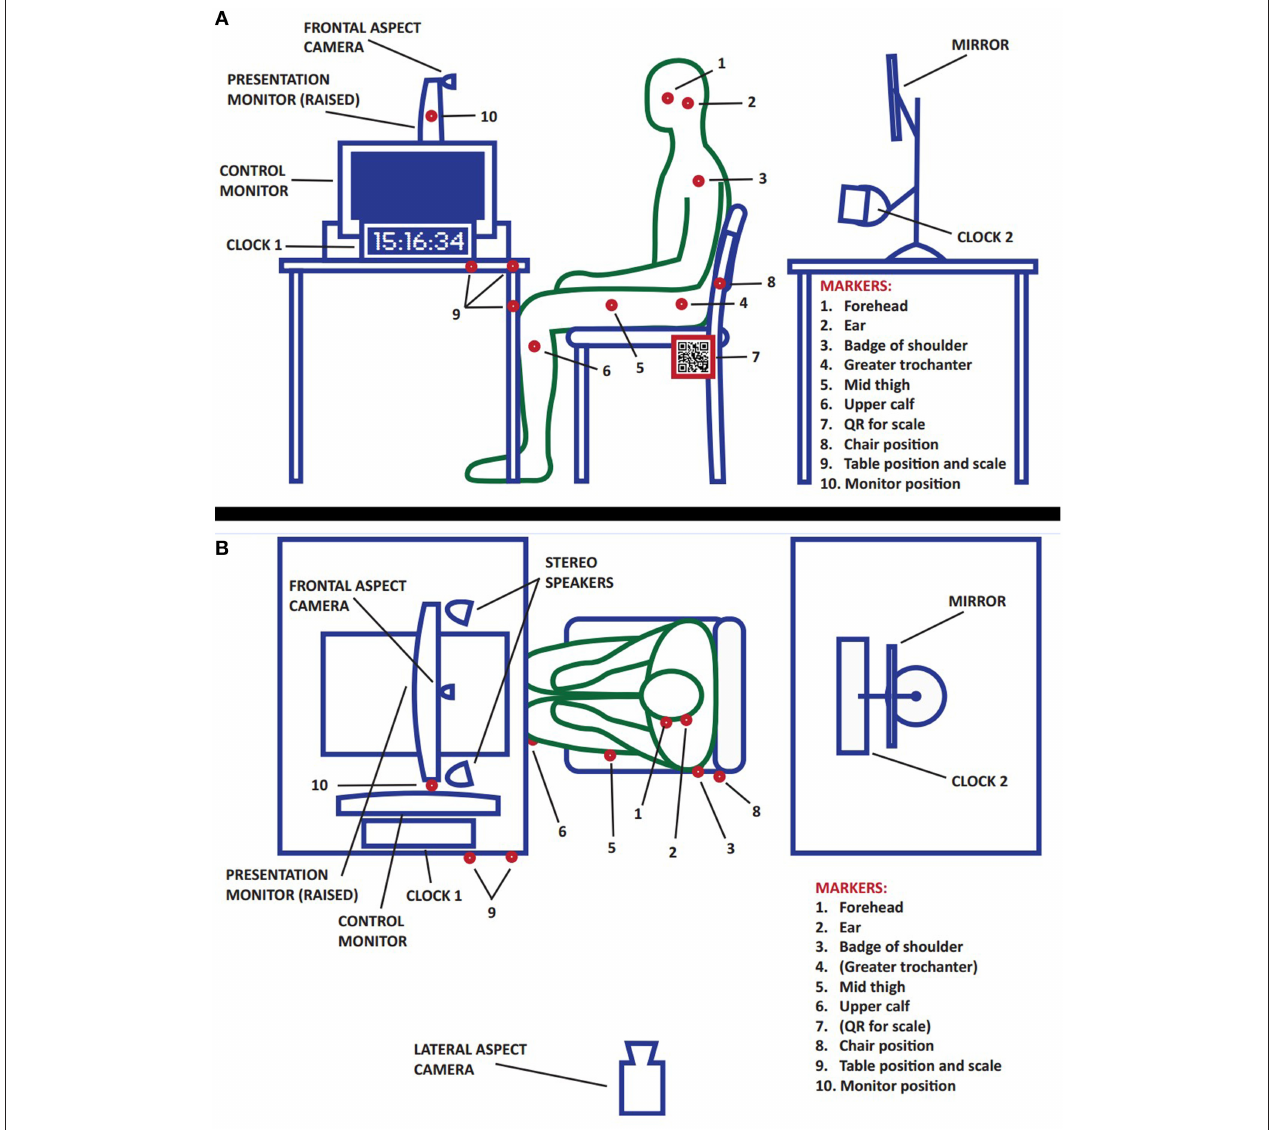
FIGURE 1 | Experimental set up: computer, participant and camera. In panel (A) , the experimental set up is shown side-on from the left (as if looking from the point of view of the lateral camera). Red dots represent the placement of reflective motion capture markers that are tracked by our system. Note that the stereo speakers are not visible because they are behind the stimulus control laptop. Clock 2 and the mirror are for use with the frontal aspect camera (focused on the face, data not presented in this study). In panel (B) , the set up is seen from above. The motion capture marker balls for the greater trochanter and the QR code are not visible from this